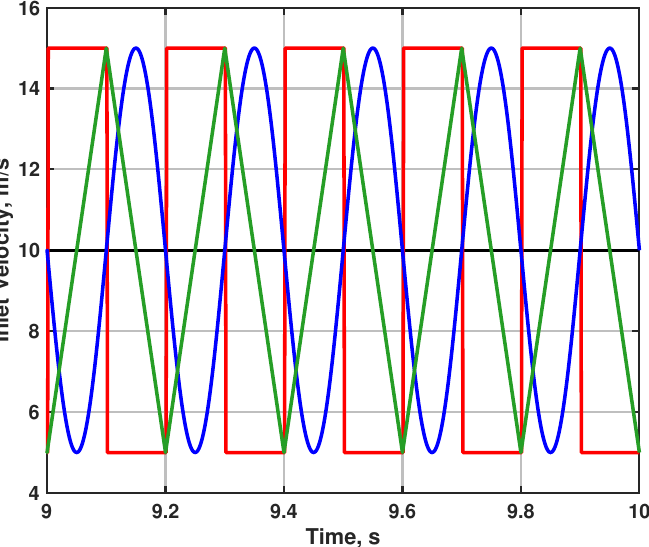
Figure 3. Inlet velocities over time as obtained in cases 1 (black), 2 (red), 3 (blue) and 4 (green).